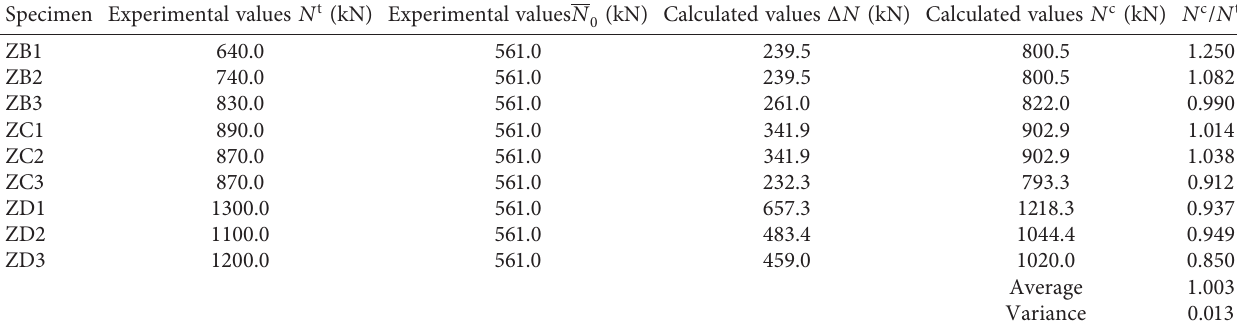
Figure 11: (a) Curve of bamboo bar ratio vs. capacity enhancement ratio. (b) Curve of mortar strengthening ratio vs. capacity enhancement Table 6: Comparison between calculated and experimental values of the limit load of columns.